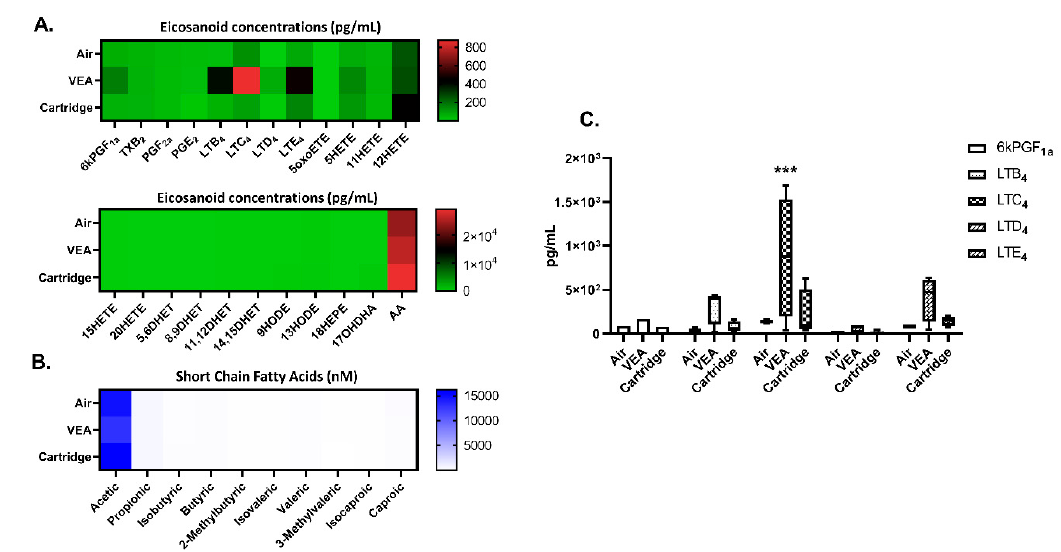
Figure 8. Eicosanoids, oxylipins, short-chain fatty acids in bronchoalveolar lavage fluid from VEA, and CBD / counterfeit vape cartridge exposed mice. Heat map generated from relative quantification by LC-MS / MS of ( A ) eicosanoids, oxylipins, and ( B ) short-chain fatty acids in BALF from mice exposed to VEA and unknown cartridges. ( C ) analytes, 6KPGF1a, LTB4, LTC4, LTD4, and LTE4 in box–whisker plots *** p < 0.001 cs. air ( n = 4 / group). p > 0.05 were considered nonsignificant and were not denoted with asterisks.